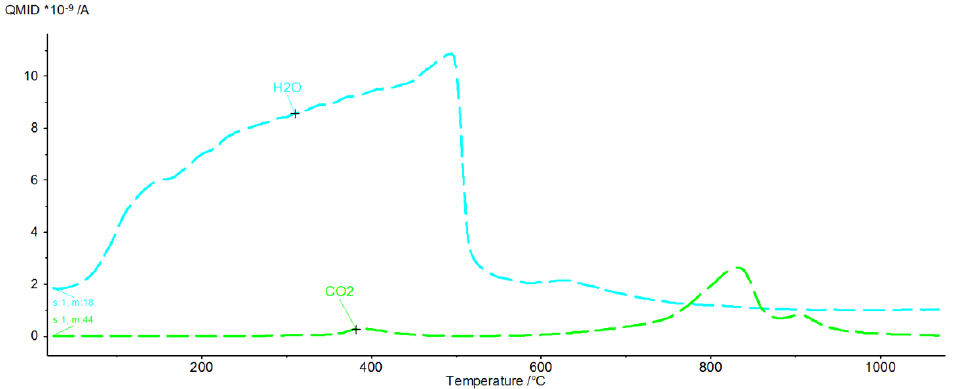
Figure 16. H 2 O and CO 2 release curves from sample K as ionic current as a function of temperature. Table 2. Weight changes in C 3 A samples stored under different conditions during heating and as- sociated thermal effects.